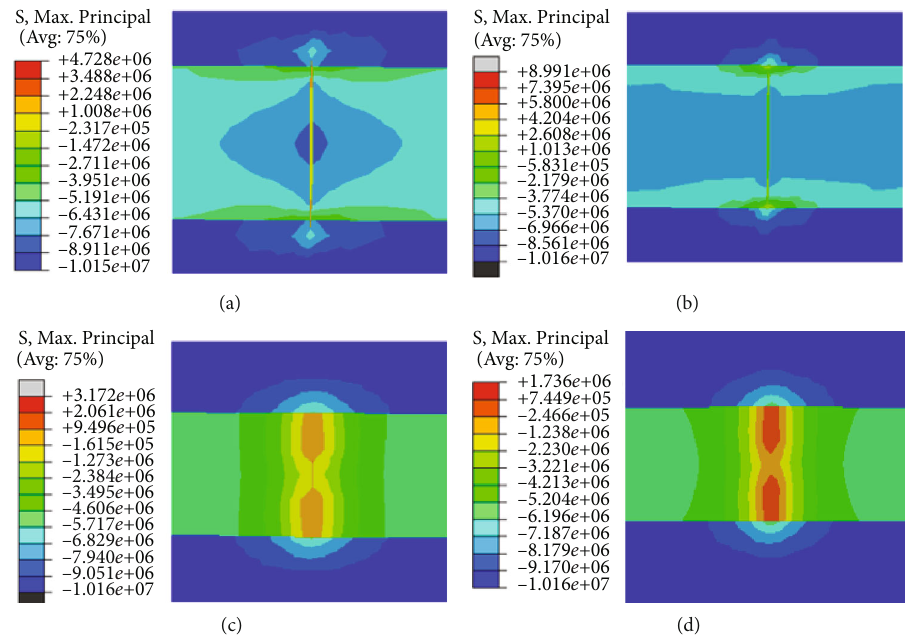
Figure 15: E ff ect of leak-o ff coe ffi cient of fracturing fl uid on the development of hydraulic fracturing height at 50 time-steps for di ff erent permeabilities: (a) 10 − 14 μ m 2 , (b) 10 − 12 μ m 2 , (c) 10 − 9 μ m 2 , and (d) 10 − 7 μ m 2